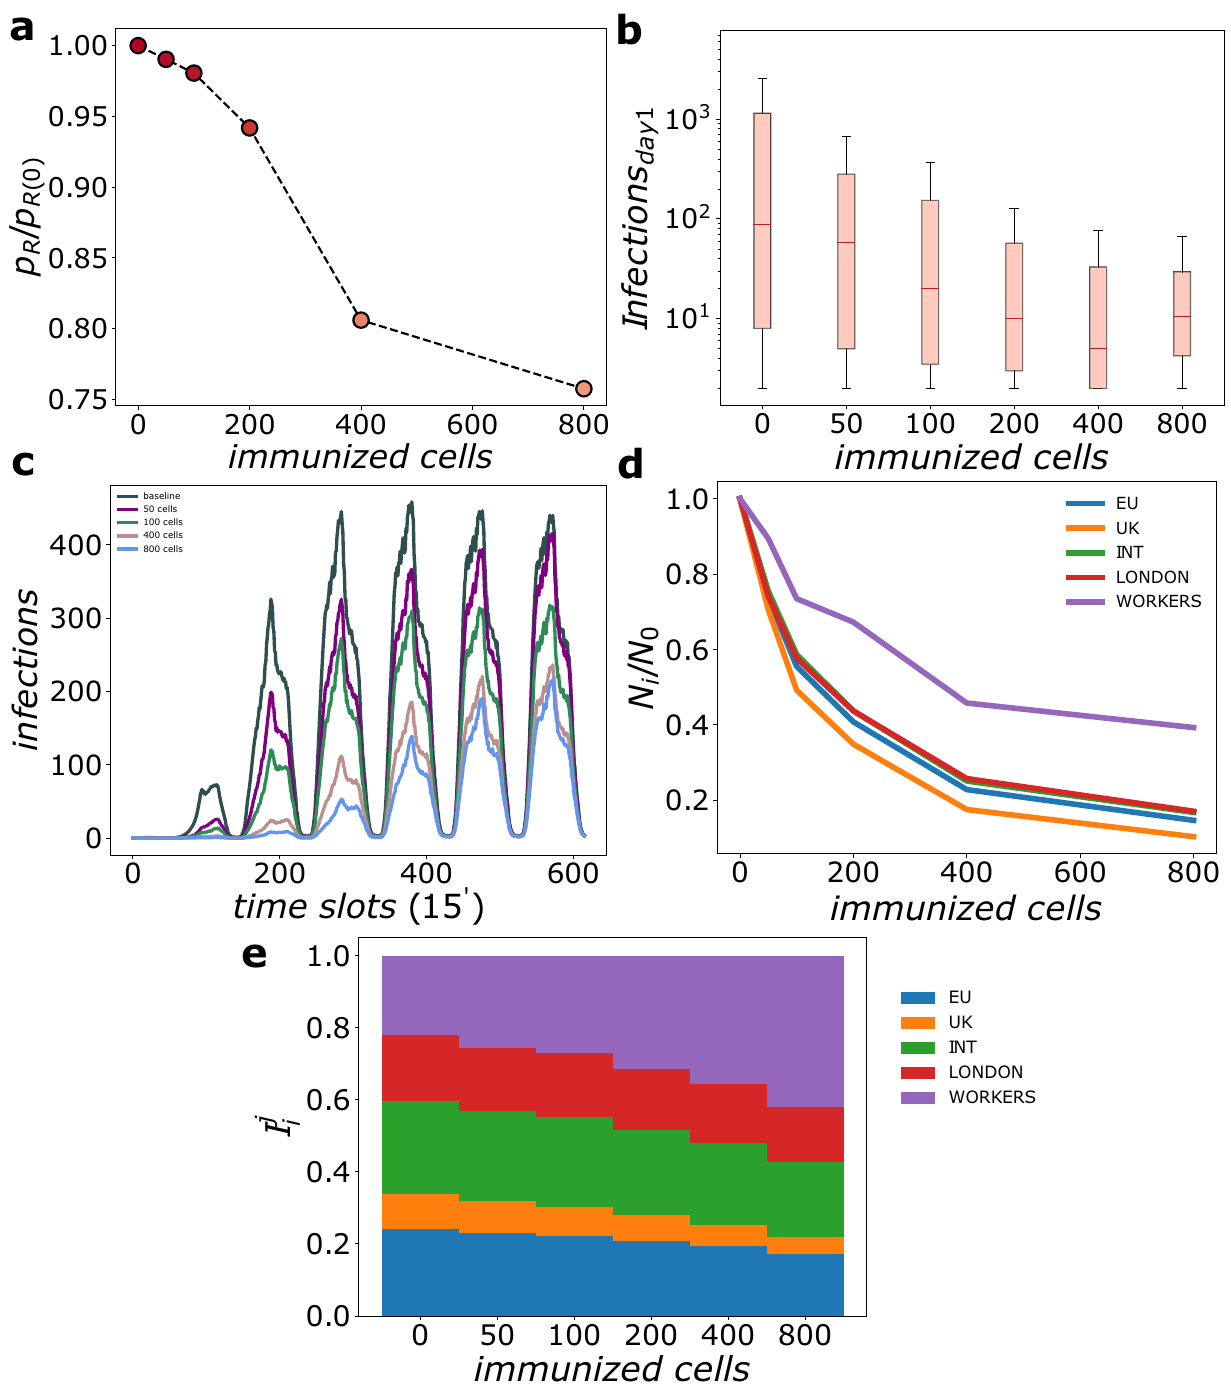
Fig.3|SpatialimmunizationeffectonSIRpropagation.a Numberofrealizations with secondary infections in the airport facilities p R as a function of the number of immunized cells, normalized to the baseline case without spatial immunization p R (0)(eachcellextensionis100 m 2 ). b Boxplot of the distribution of contagionsin the fi rst 24 hours. Medians are shown as red lines, boxes represent the IQR, whis- kers extend to 1.5×IQR above and below the 75 and 25 percentile respectively. c New infections per time slot as a function of time and for different spatial